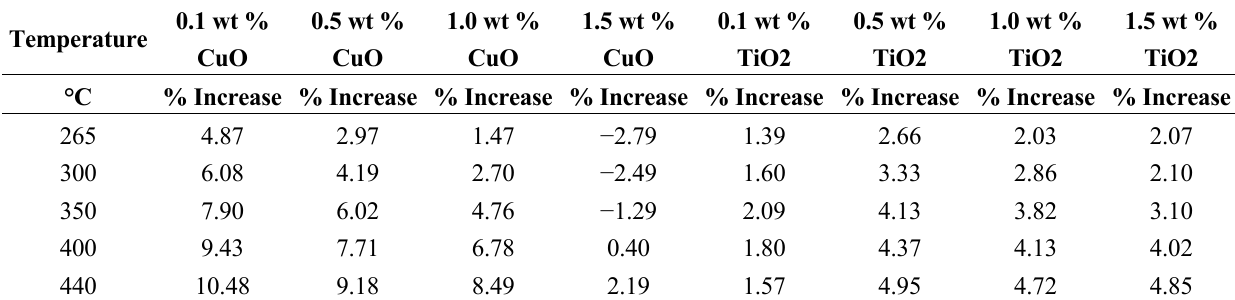
Figure 1. Specific heat capacity ( C p ) measurements: ( A ) 0.1 to 1.5 wt % CuO addition to 60/40 mixtures of Na/K-NO 3 ; ( B ) 0.1 to 1.5 wt % TiO 2 addition to 60/40 mixtures of Na/K-NO 3 . Table 1. Percentage increase in specific heat capacity ( C p ) compared to base salt for different concentrations of CuO and TiO 2